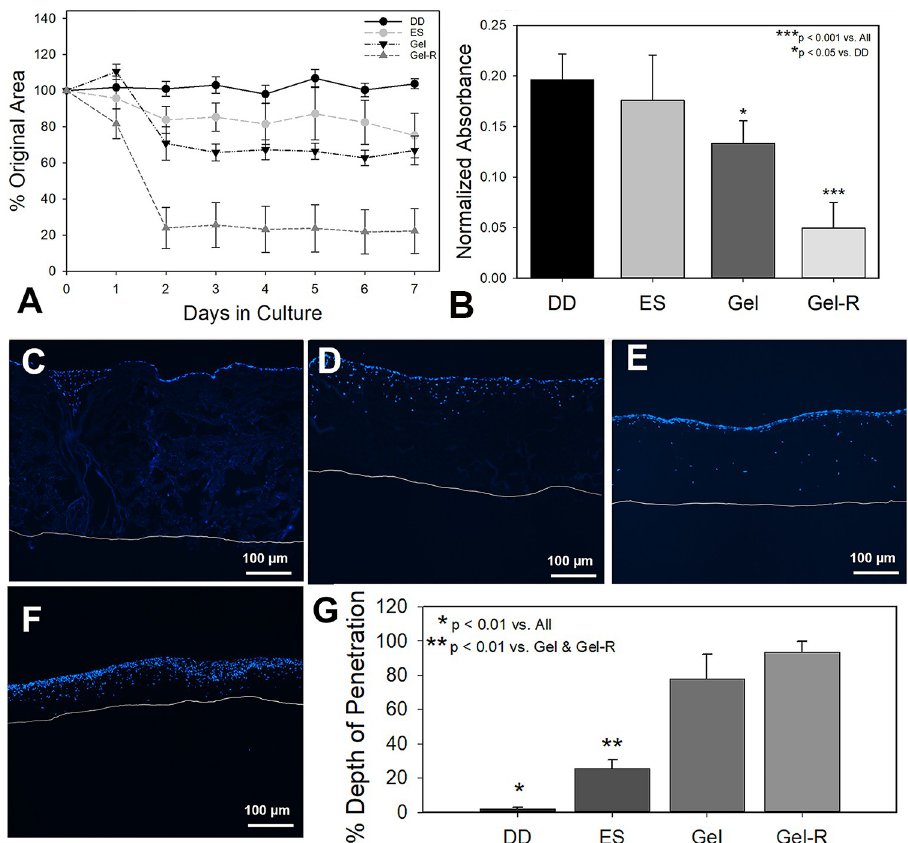
Fig 2. Lamina propria engineered with different scaffold systems. Multiple scaffold systems were considered for the development of human engineered gingiva including decellularized dermis (DD), electrospun collagen (ES), collagen gels cast over a membrane (Gel) and collagen gels cast into a standard culture plate and released (Gel-R). A) Contraction of engineered lamina propria as a function of culture time. B) Normalized MTT cell viability assay at day 7. DAPI stained cryosections of engineered lamina propria after 7 days of culture on C) decellularized dermis, D) electrospun collagen, E) collagen gel, and F) collagen gels that were released. White line indicates the bottom of each substrate. G) Quantification of the depth of penetration into each